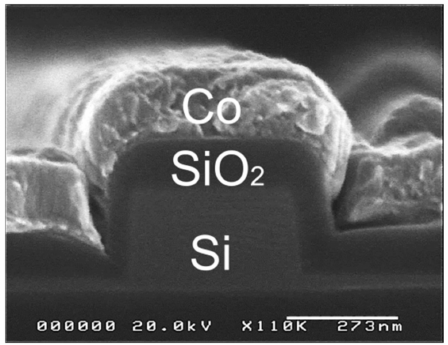
Figure 2. A cross sectional SEM image of Si plasmonic waveguide.